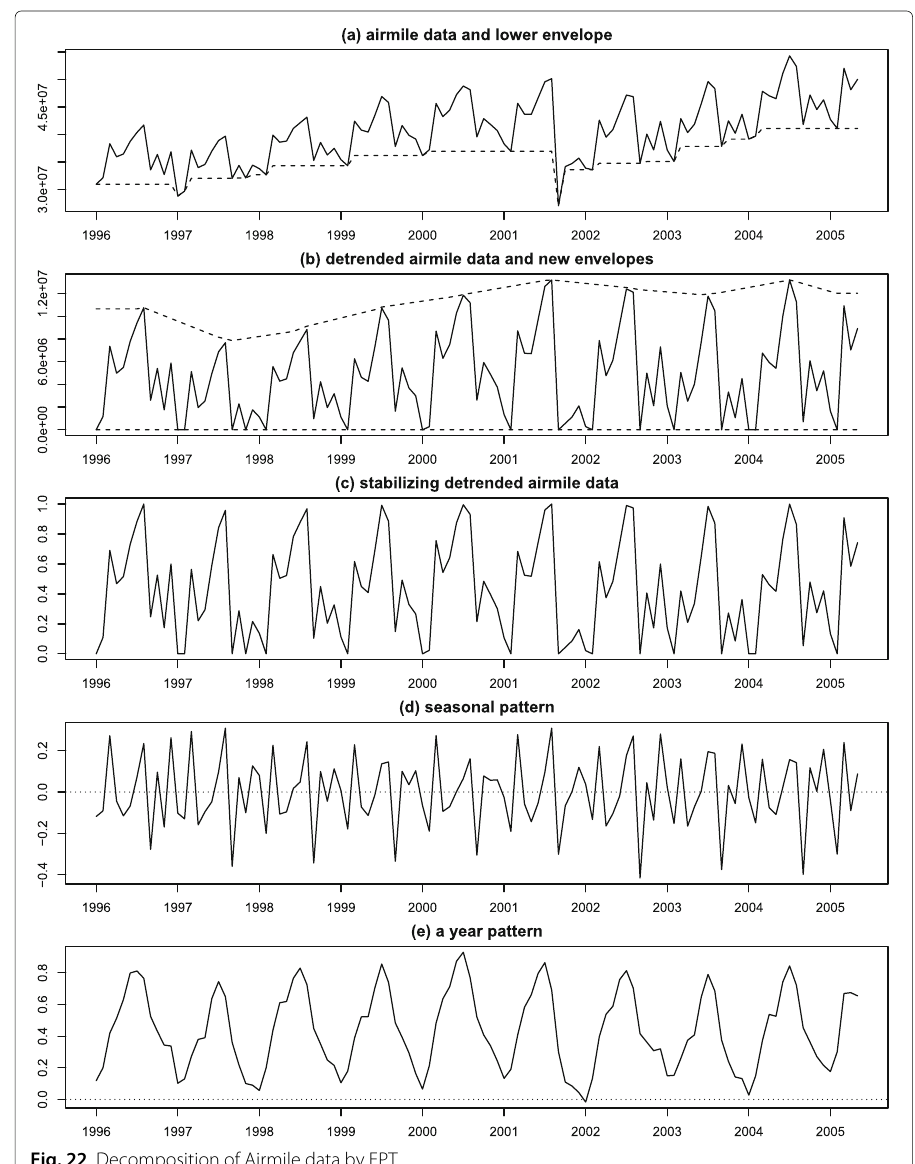
Fig. 22 Decomposition of Airmile data by EPT